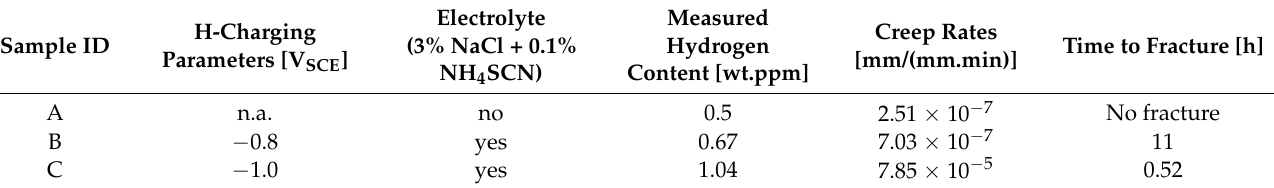
Table 2. Effect of increasing critical hydrogen content on creep rates during constant load tests.